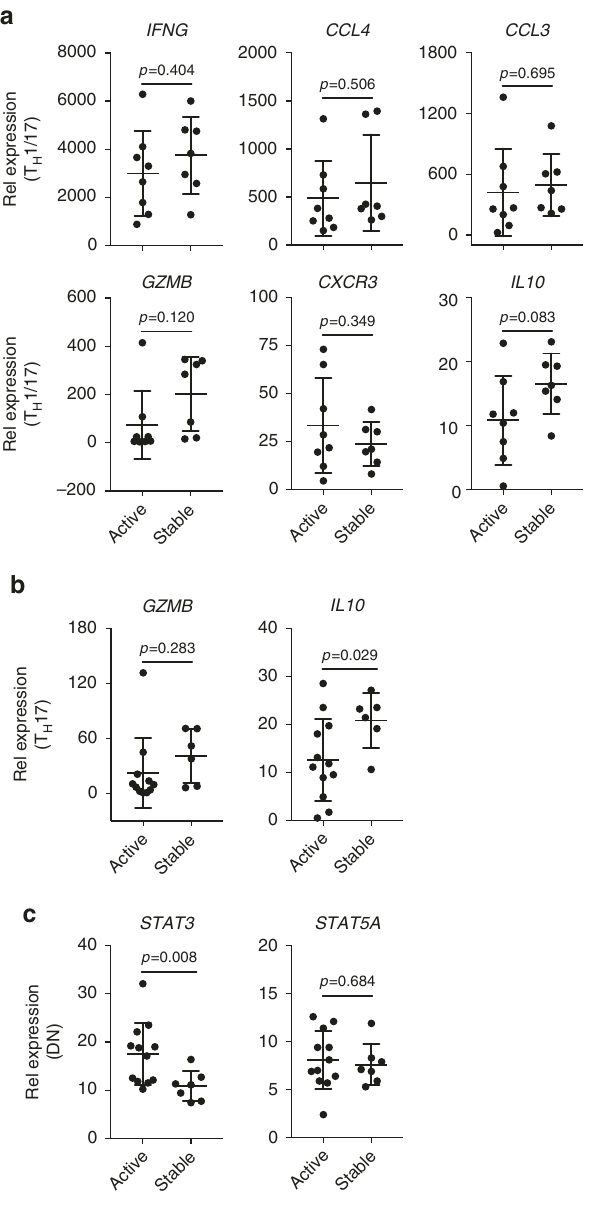
Fig. 7 Correlation of IL10 and STAT3 expression with disease activity in MS. The mRNA levels of signature genes with altered expression in MS (Fig. 6) were compared between active and stable patients. Signature gene expression in a T H 1/17 (active, n = 8; stable, n = 7), b T H 17 (active, n = 12; stable, n = 6), and c DN cells (active, n = 12; stable, n = 7) (Welch ’ s t test, mean ±